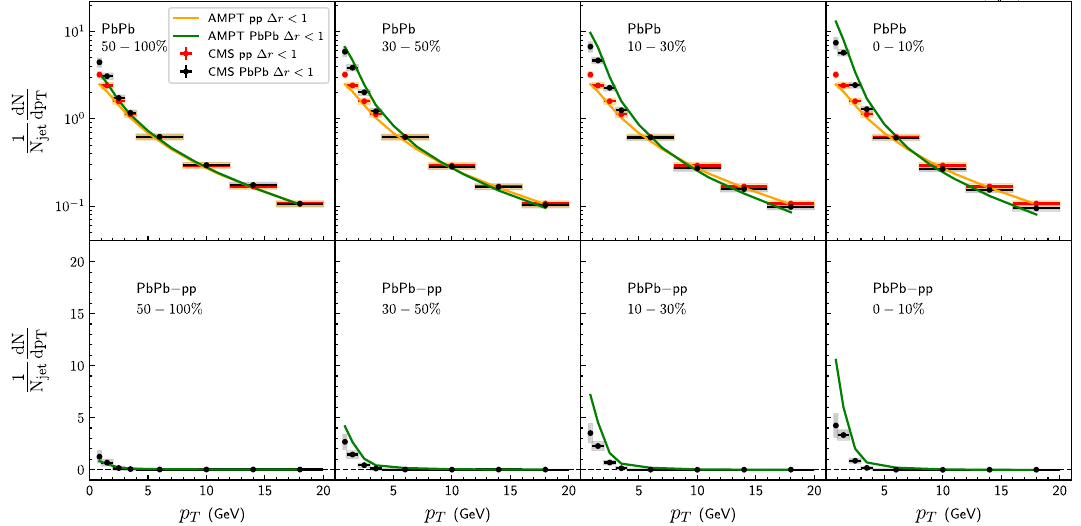
Fig. 3 Jet-correlated charged particle yield distribution around the jets in the region (cid:2) r < 1 as a function of charge particle p T for Pb + Pb and p + p collisions from the AMPT model and compare to CMS data [66] (upper panels). The differences between Pb + Pb and p + p